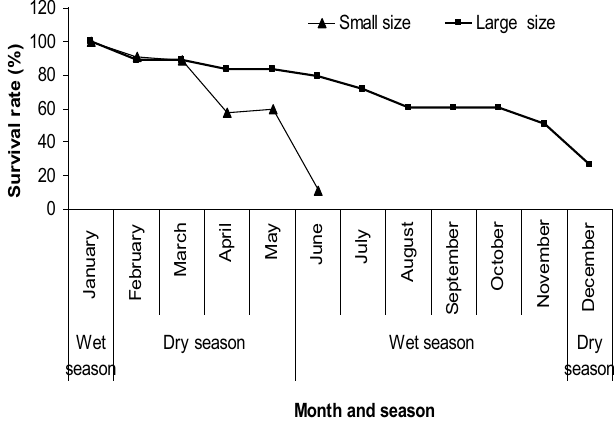
Fig. 3. Survival rate of small- and large-sized groups of freshwater